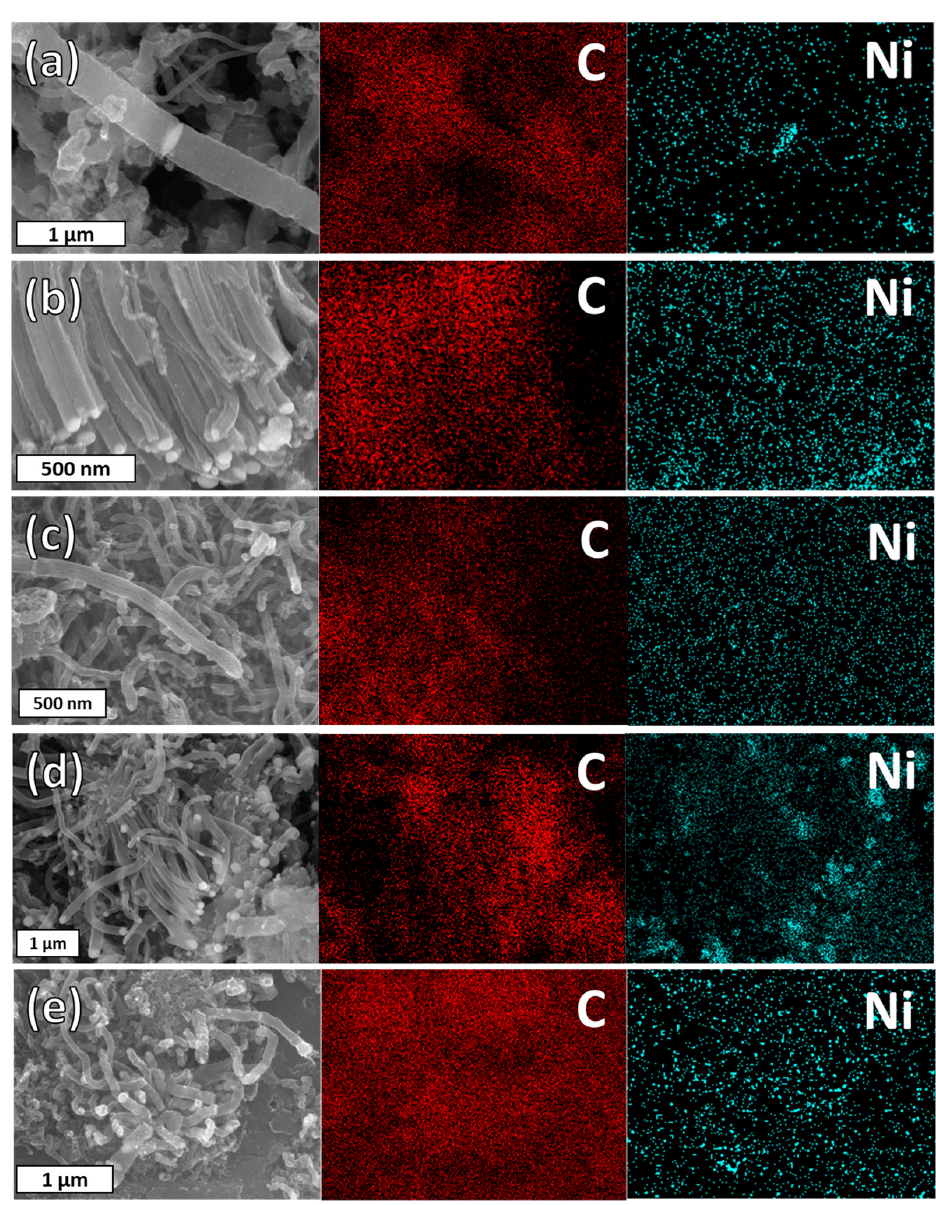
Figure 5. Elemental composition of carbon fibers grown by ( a ) benzene, ( b ) dichlorobenzene, ( c ) NMP, ( d ) ethanol, and ( e ) methanol SPGS by energy-dispersive X-ray spectroscopy (EDX).